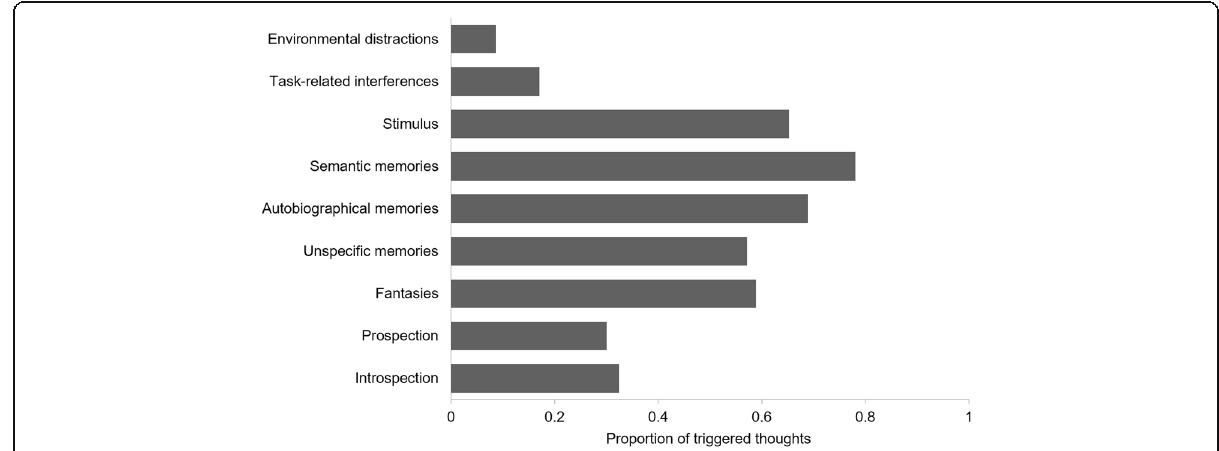
Fig. 2 Proportion of triggered thoughts per